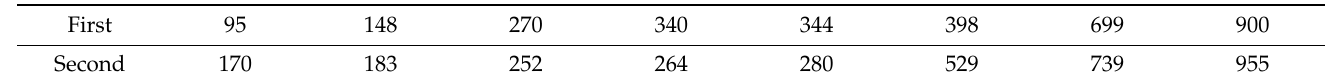
Table 4. Top eight sites with the largest absolute values of eigenvector elements in the first and second left-singular vectors of SVD.